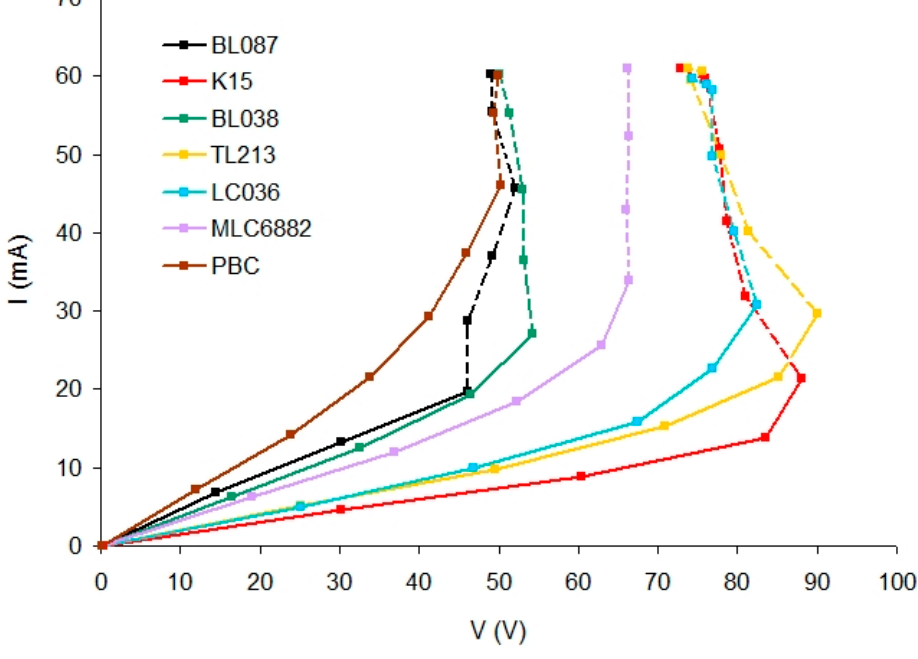
Figure 3. Electric current intensity versus root mean square (RMS) voltage for holographic polymer dispersed liquid crystal (HPDLC) devices with different LC.